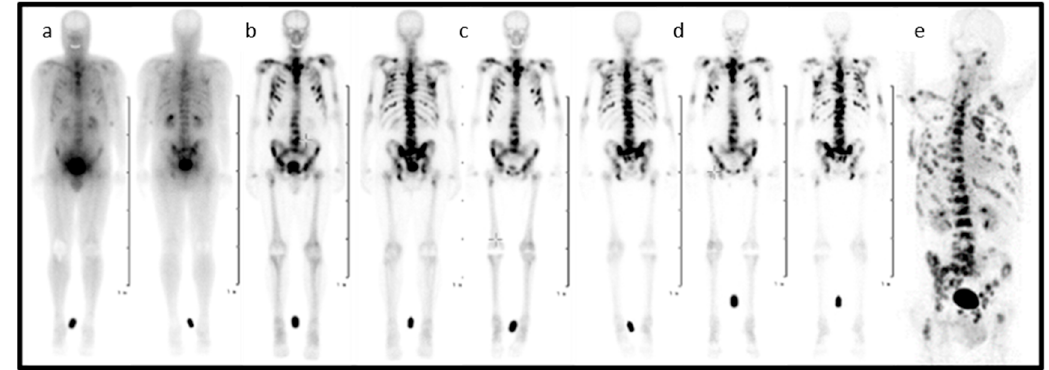
Figure 2. Planar scintigraphy (anterior and posterior) of [ 177 Lu]Lu-DOTA-ZOL at different time points ( a – d ) and PET/CT of gallium-68 [ 68 Ga]Ga-DOTA-ZOL ( e ) in a bronchial carcinoma patient with secondary bone metastases [41].